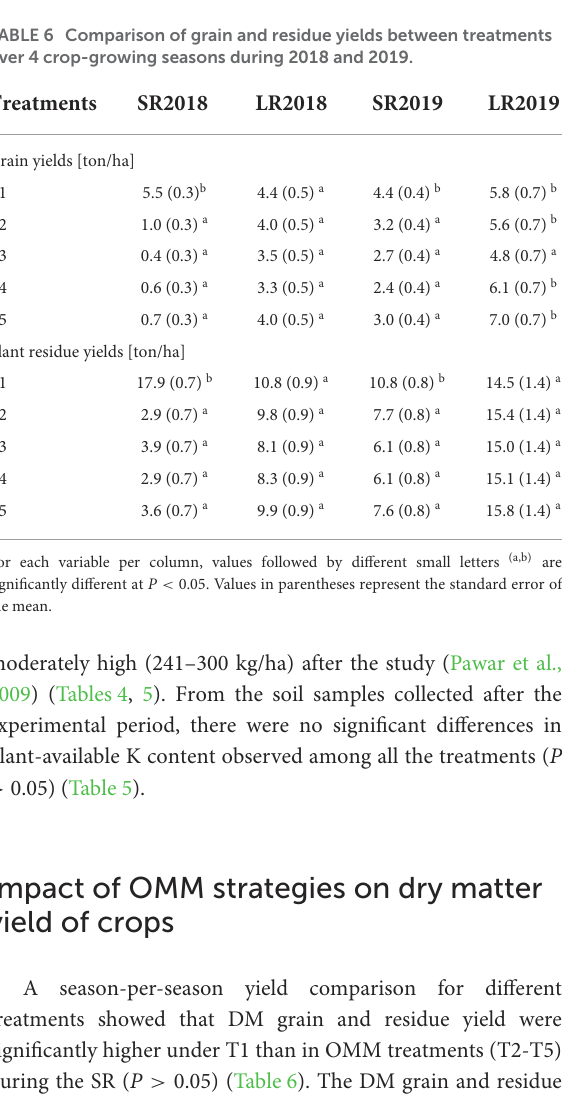
TABLE 5 Comparison of soil physical-chemical characteristics between treatments after the experiments in January 2020. Characteristics T1